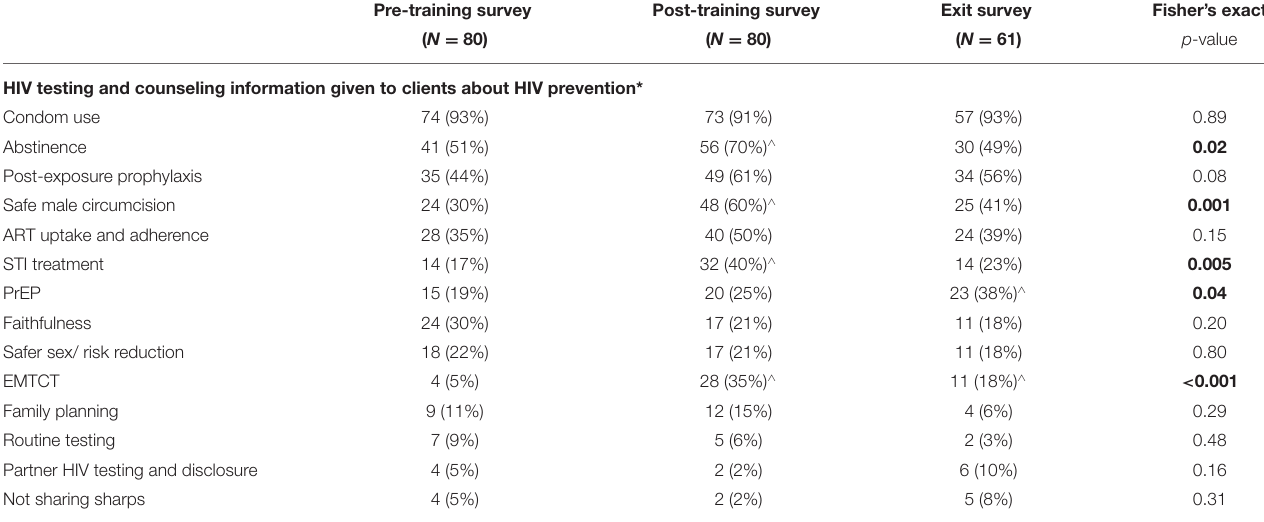
TABLE 2 | HIV prevention